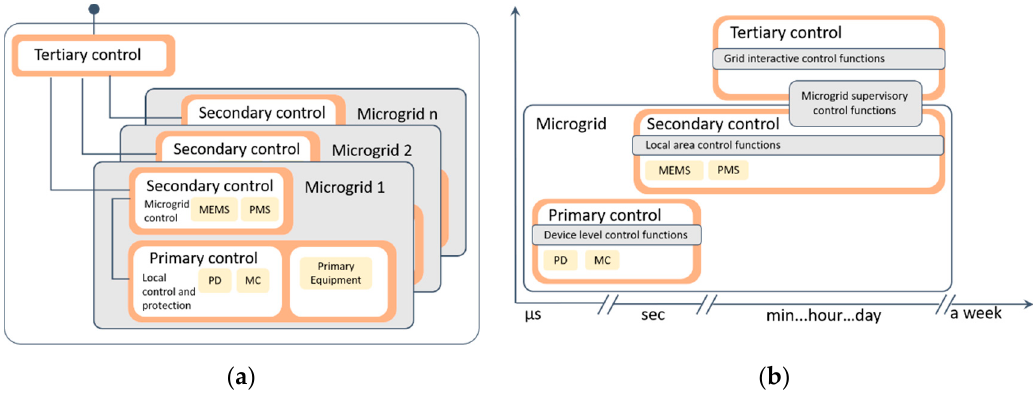
Figure 1. Three control levels of a microgrid management system. ( a ) Hierarchical control levels: primary control, secondary control, and tertiary control. Adapted from [1]. ( b ) Microgrid control system time-frame and action time domain. Adapted from [6].